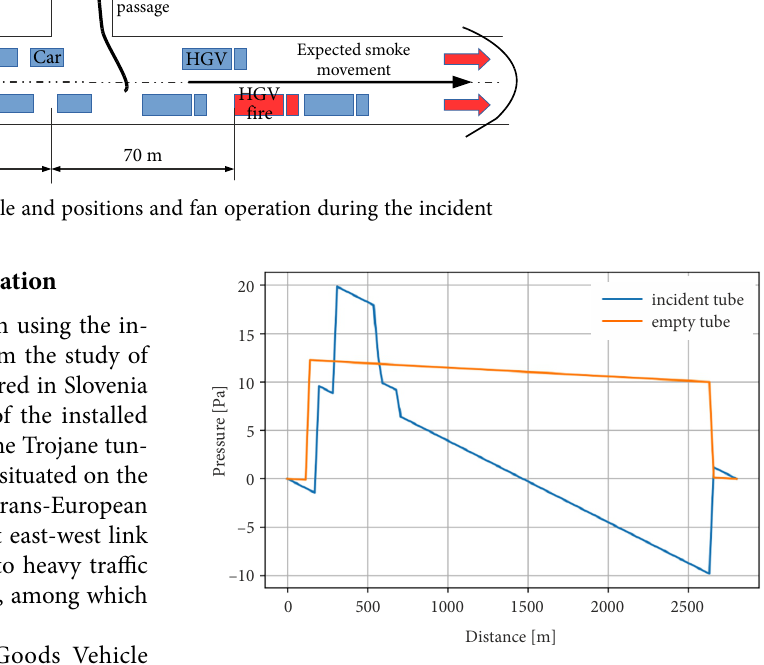
Figure 17. Pressure distribution during the